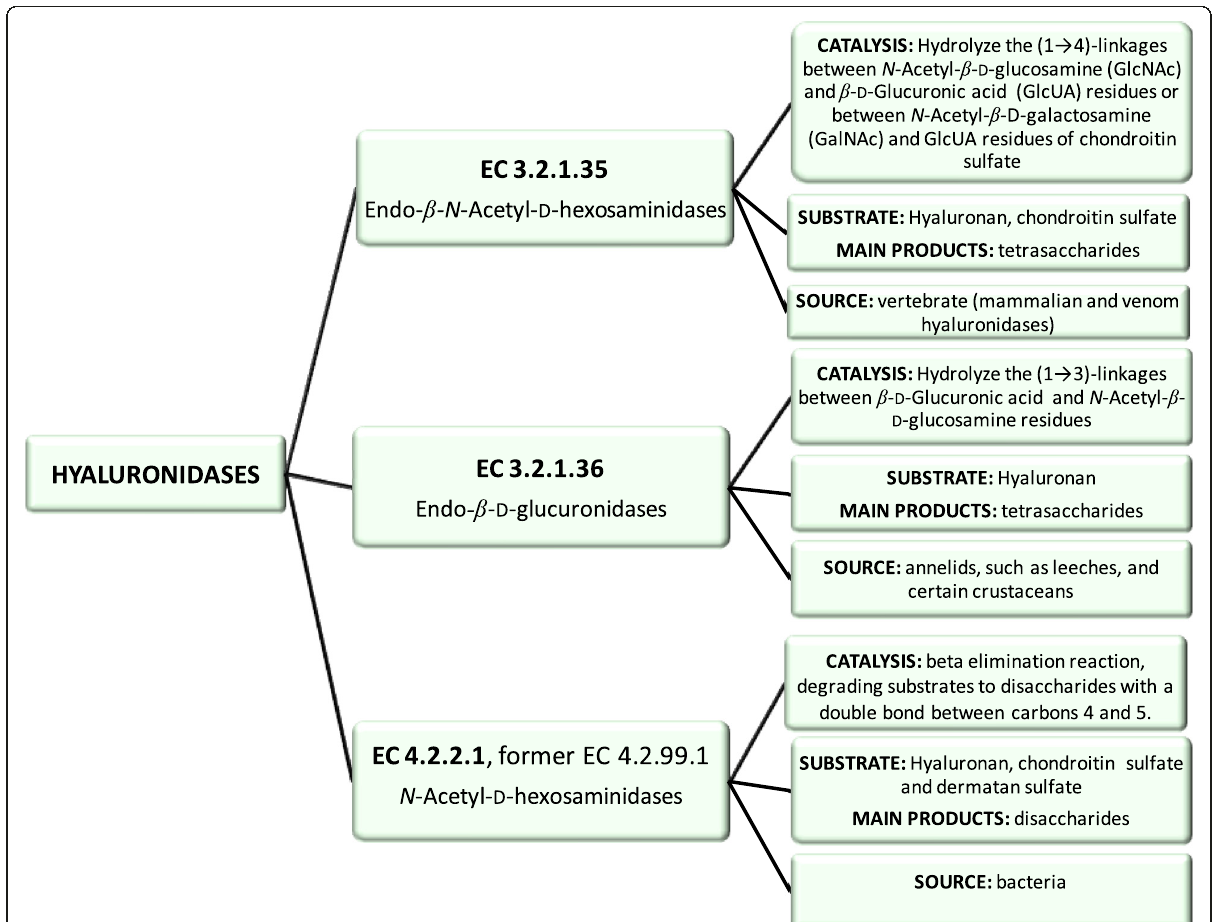
Fig. 2 The three major groups of hyaluronidases. The EC numbers, catalysis, substrates, main products and sources of each hyaluronidase group are